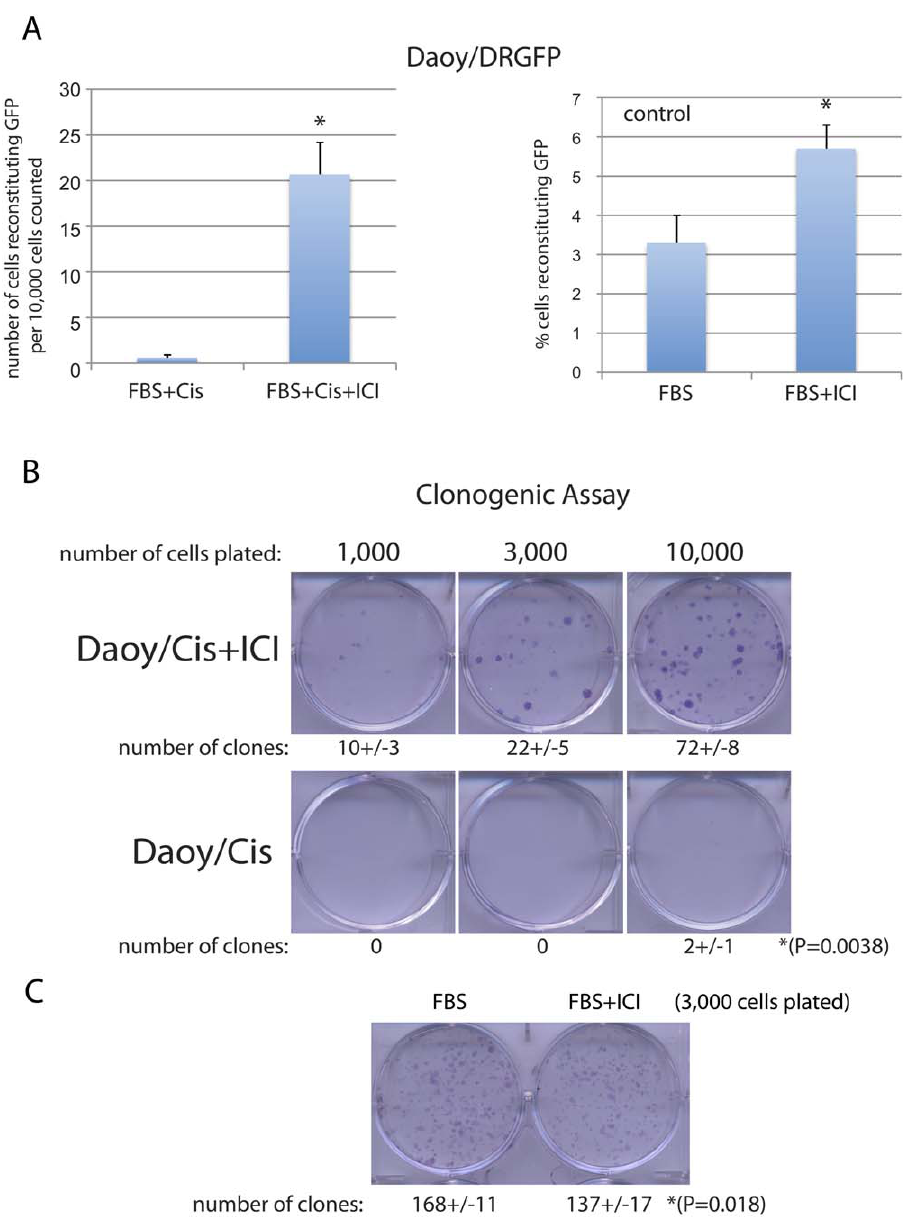
Figure 7. Inhibition of ER b improves homologous replication directed DNA repair (HRR) and increases clonogenic growth of Daoy cells treated with cisplatin. Panel A: HRR was evaluated by the assay based on the reconstruction of the wild type green fluorescent protein (GFP) from two non-functional heteroallelic fragments of GFP cDNA delivered into cells by the pDRGFP expression vector [37]. HRR was evaluated in Daoy/DRGFP cells following transient transfection with the expression vector coding for I- Sce-I (rare cutting endonuclease), to inflict DNA double strand break in GFP cDNA, and with mito-red containing expression vector (control for the efficiency of transfection). The results were collected from three separate experiments in duplicate (n=6) in which about 10,000 transfected cells per experiment were counted in at least ten randomly selected microscopic fields. * indicates value statistically different from the sample labeled Cis (paired student t-test; P # 0.05). The histogram labeled ‘‘DRGFP control’’ illustrates baseline HRR in exponentially growing Daoy cells in 10%FBS and in 10%FBS + 10 m M ICI182,780. Panel B: Clonogenic assay. The monolayer cultures of Daoy cells were exposed to cisplatin (0.25 m g/ml) in the presence and in the absence of 10 m M ICI182,780 for 24 hours. Next, the medium containing cisplatin was replaced with the fresh medium and the cells were plated at the clonal-density (ranging from 1 6 10 3 to 1 6 10 4 cells per 35 mm dish) in the presence of 10%FBS. Clonogenic growth was evaluated after 14 days of a continuous cell growth as described in our previous work [50]. In control conditions (Panel C), the cisplatin treatment was omitted. The data represent average number of clones with standard deviation calculated from three independent experiments in duplicate (n=6) *indicates values statistically different (paired student t-test; P # 0.05). doi:10.1371/journal.pone.0033867.g007 from 100 cells collected per single measurement by utilizing single cell electrophoresis in neutral conditions [32] by utilizing SYBR green based kit from Trevigen and Automated Comet Assay specialized comet software included in the Automated Comet System from Loats Associates Inc. The tail moment was calculated Assay System (Loats Associates Inc., Westminster, MD).